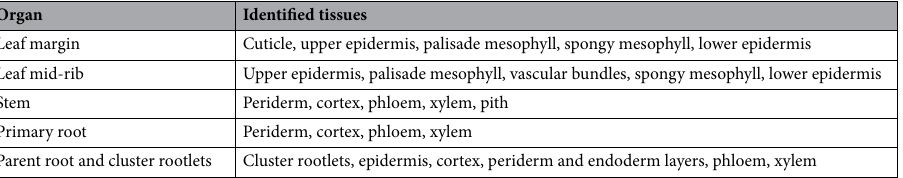
Table 1. Tissues identified in the different organs of Grevillea meisneri . Tissues were described from the outside to the inside of the corresponding organ.